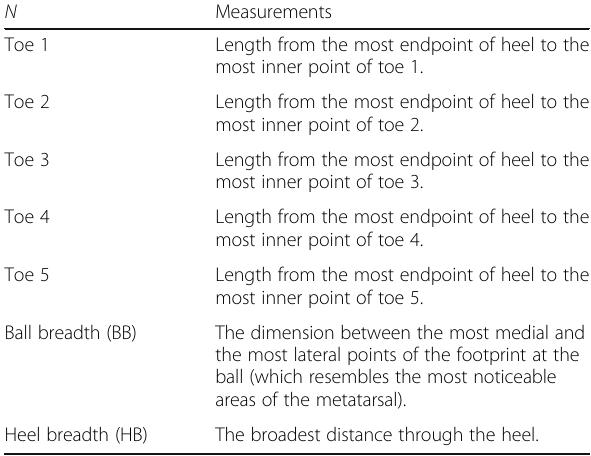
Table 1 Parameters and their measurements